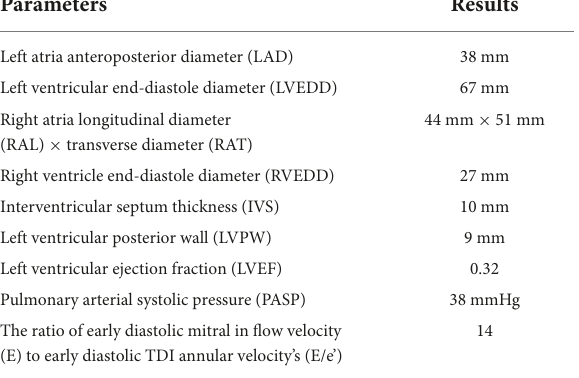
( Figure 1 ). Cardiac magnetic resonance imaging (MRI) indicated LV dilation (66 mm), thinning of the left ventricle region wall (3 mm) and abnormal motion and suggested transmural infarction at the apex (orange arrow) and the lateral wall (blue arrow) and partial infarction at the anterior wall (yellow